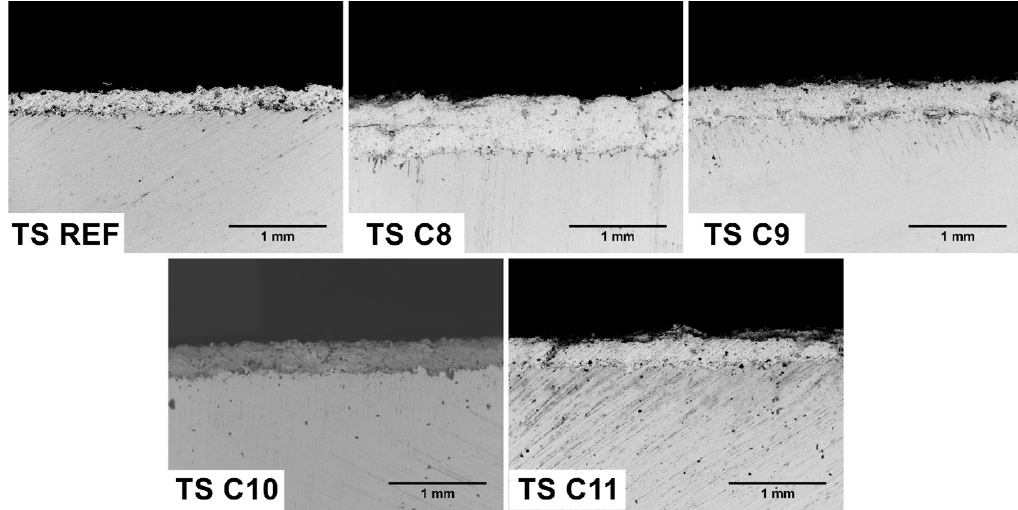
O coating by thermal spray (TS) samples exposed to in-situ test. 2 5